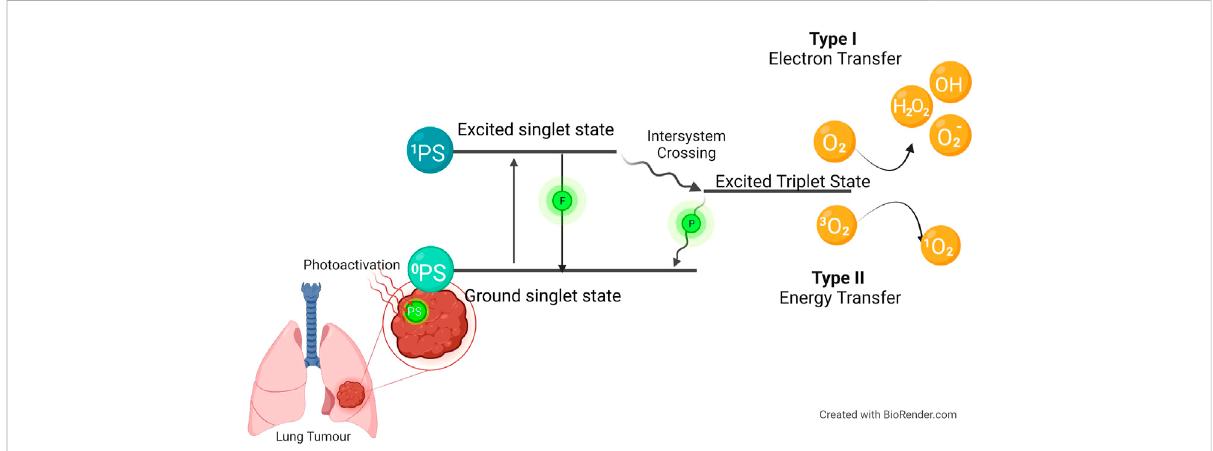
FIGURE 1 The mechanism of photodynamic therapy (PDT). The photosensitizer (PS) is absorbed when the PS is in its ground state. It goes into its fi rst excited singlet state because of photoactivation. This state can be broken down by emitting fl uorescence, or it can cross over to the more stable excited triplet state. Type I is when the PS in its excited triplet state reacts with biomolecules (such as lipids, proteins, and nucleic acids), and the radical mechanism is used to transfer hydrogen atoms. It generates free radicals and radical ions (the type of radical varies depending on the target molecule, such as lipids, proteins, or nucleic acids), which react with oxygen to produce reactive oxygen species. Type II reactions are based on a phenomenon known as triplet – triplet annihilation. In these reactions, the PS in its excited triplet state reacts with oxygen in its triplet ground state. This results in the formation of highly reactive and cytotoxic singlet oxygen.